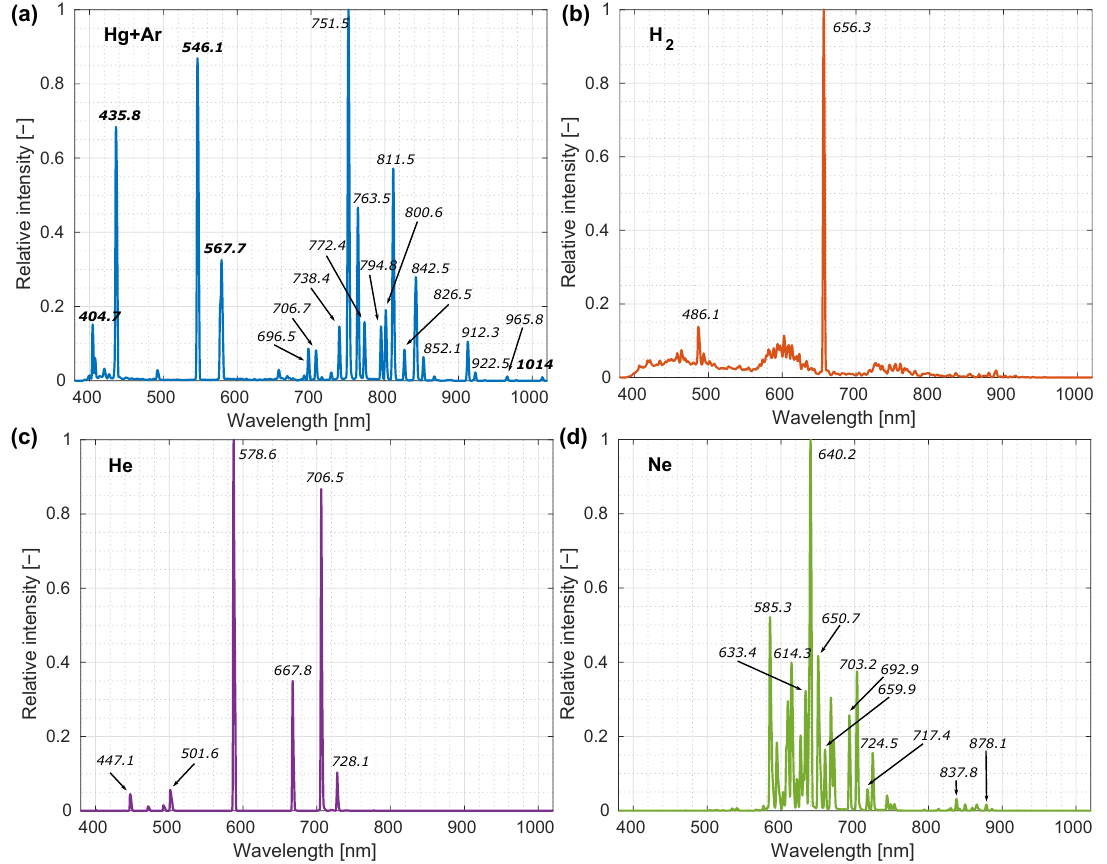
Figure 3. Gas vapor emission spectra with characteristic spectral lines used for the system spectral calibration are displayed for four different gases: ( a ) mercury vapor (with argon as an inert gas), ( b ) hydrogen, ( c ) helium and ( d ) neon. Spectra are acquired using the custom-made laboratory hyperspectral imaging (HSI) system; the calibrated wavelength x -axis is used to plot the data; lines that were used for calibration are annotated with characteristic wavelengths in